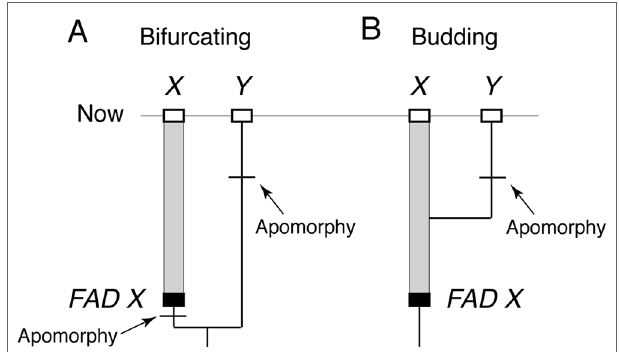
FIGURE 2 | The importance of apomorphy-based FAD s when establishing minimum age constraints. (A) When lineage X has an apomorphy with respect to lineage Y , then oldest fossil of X , FAD X , can be used as minimum age constraint on the divergence of X and Y . (B) However, if X lacks apomorphies with respect to Y , then the age of FAD X does not constrain the divergence time of X and Y because Y could have budded off X at any time. Note: without a fossil record of Y , it is not possible to place a minimum age constraint on when its apomorphy evolved.